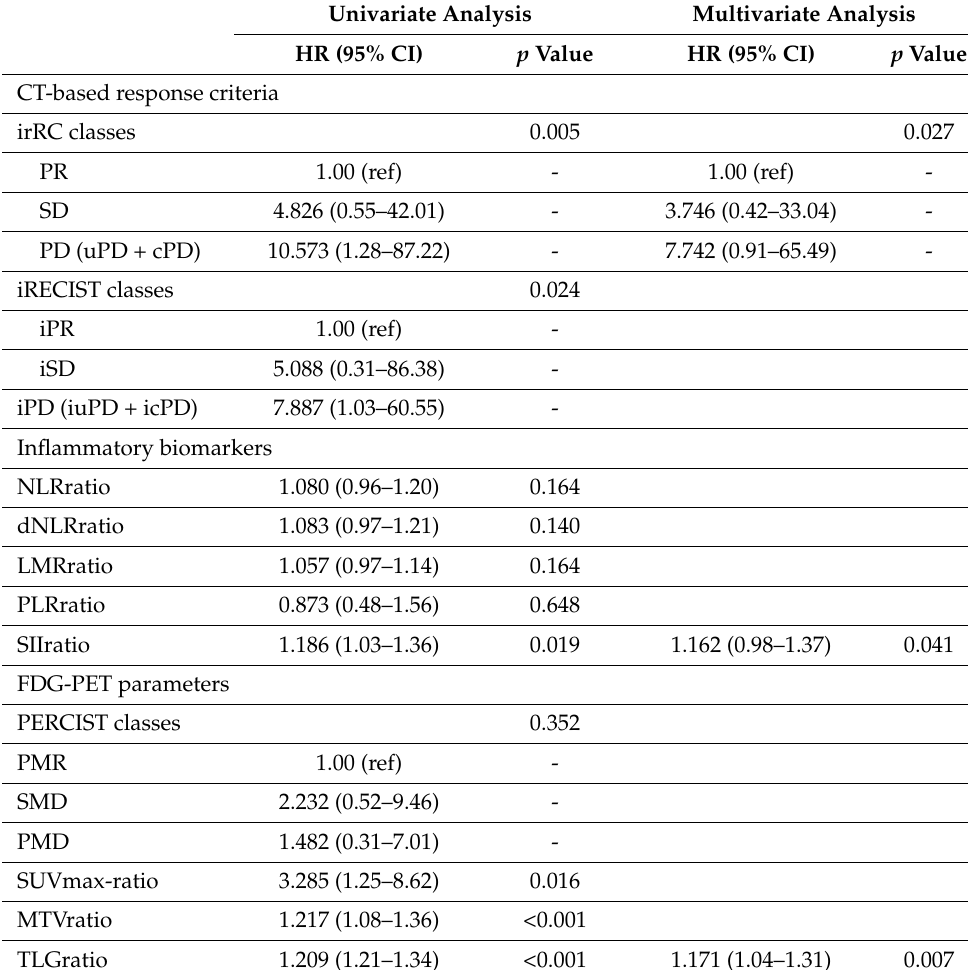
Table 3. Systemic inflammation and FDG PET/CT parameters in the evaluation of response. Univariate